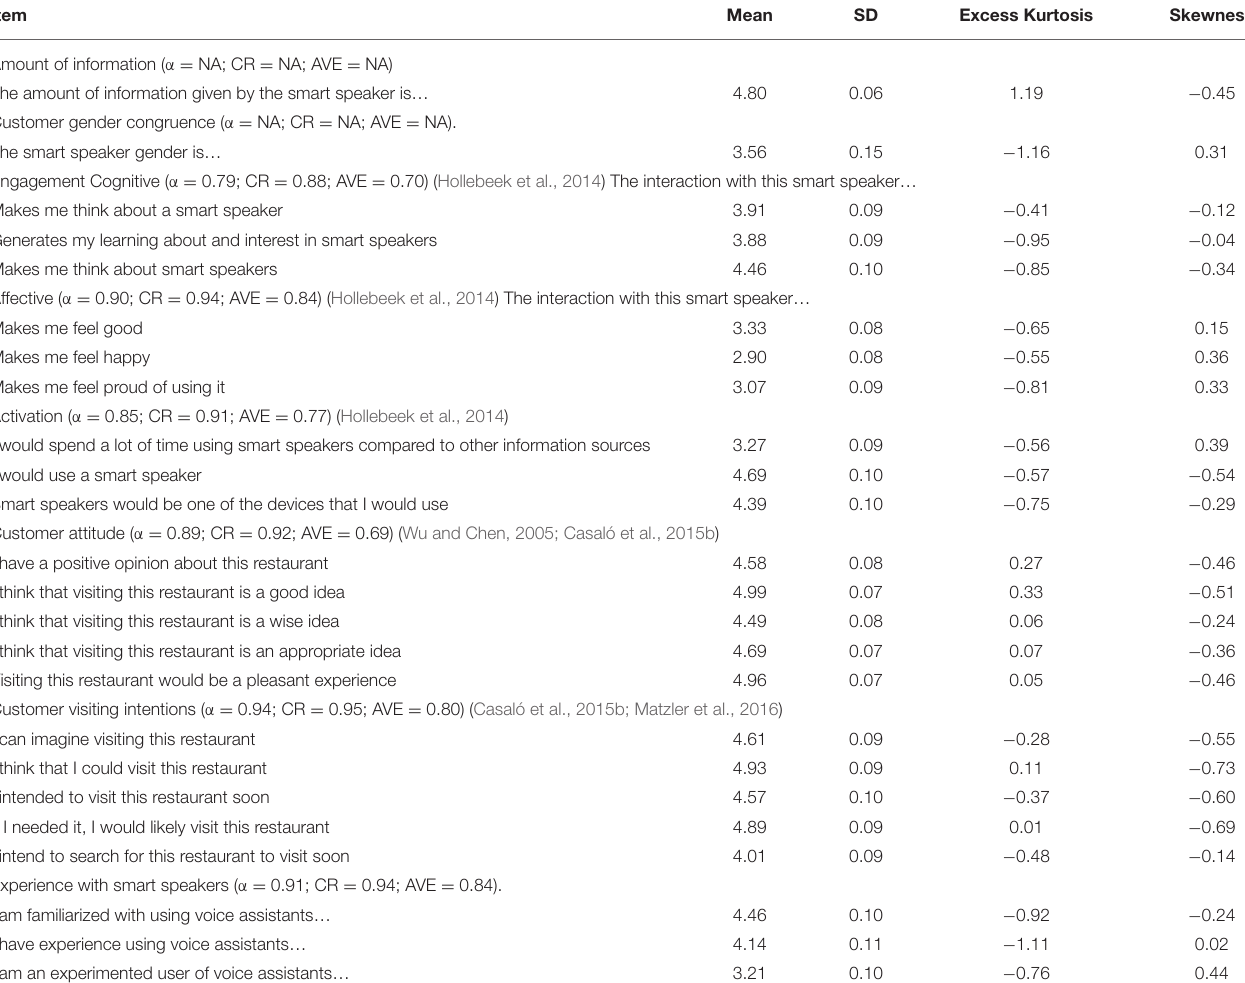
TABLE 2 | Measurement items. Item Mean SD Excess Kurtosis